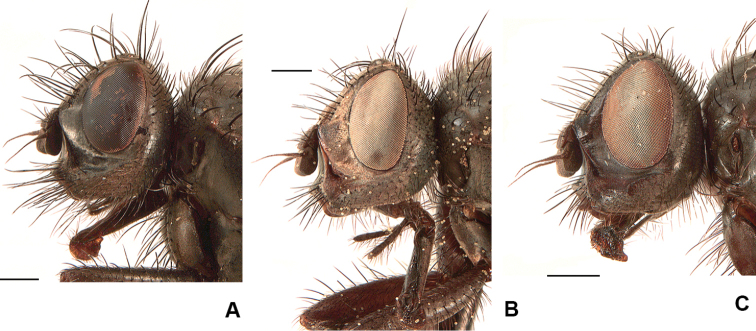
Female heads AD.
spinitarsisBD.
pribilofensisCD.
setibasis. Scale bars: 0.5 mm.